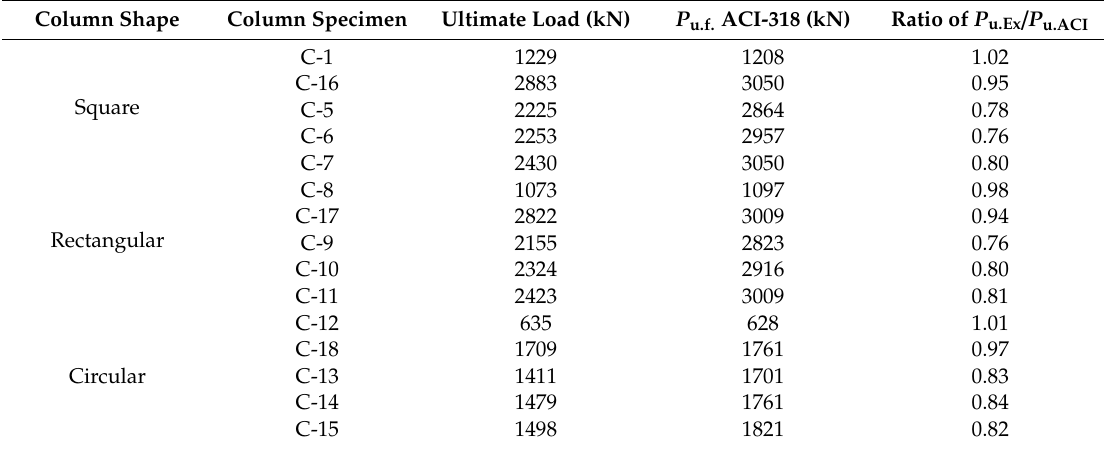
Table 5. Summary of the loads of the RC columns strengthened with RC jacketing and predicted using the ACI-318 code